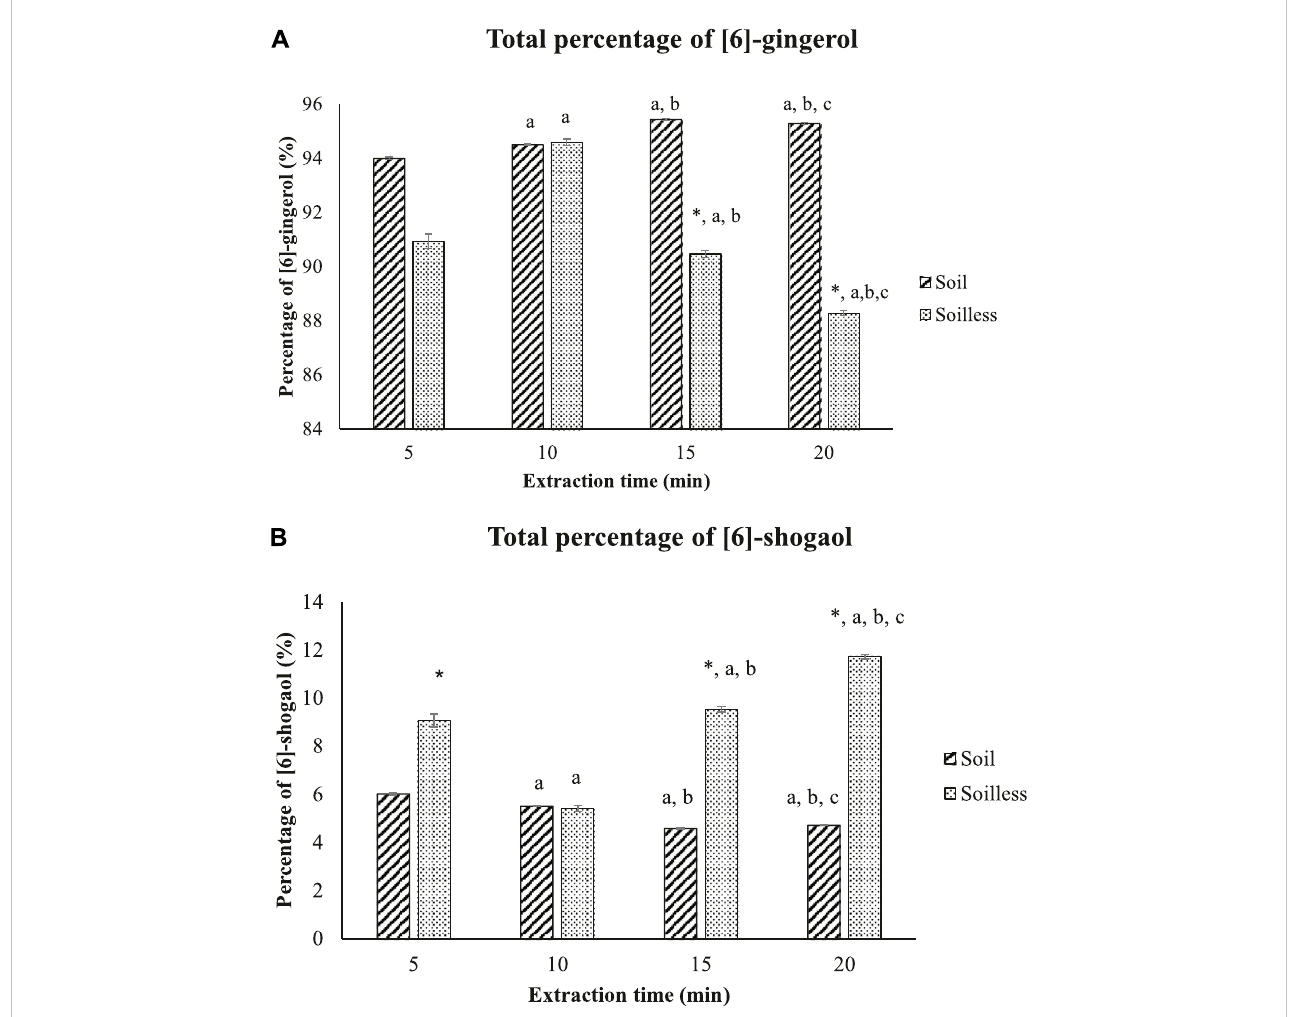
FIGURE 4 Percentage of [6]-gingerol (A) and [6]-shogaol (B) in both soil and soilless ginger. Data presented as mean ± SD (n = 6), * p < .05 indicates a signi fi cant difference from the soil at the indicated extraction time; a p < .05 indicates a signi fi cant difference from the extraction time of 5 min; b p < .05 indicates a signi fi cant difference from the extraction time of 10 min; c p < .05 indicates a signi fi cant difference from the extraction time of 15